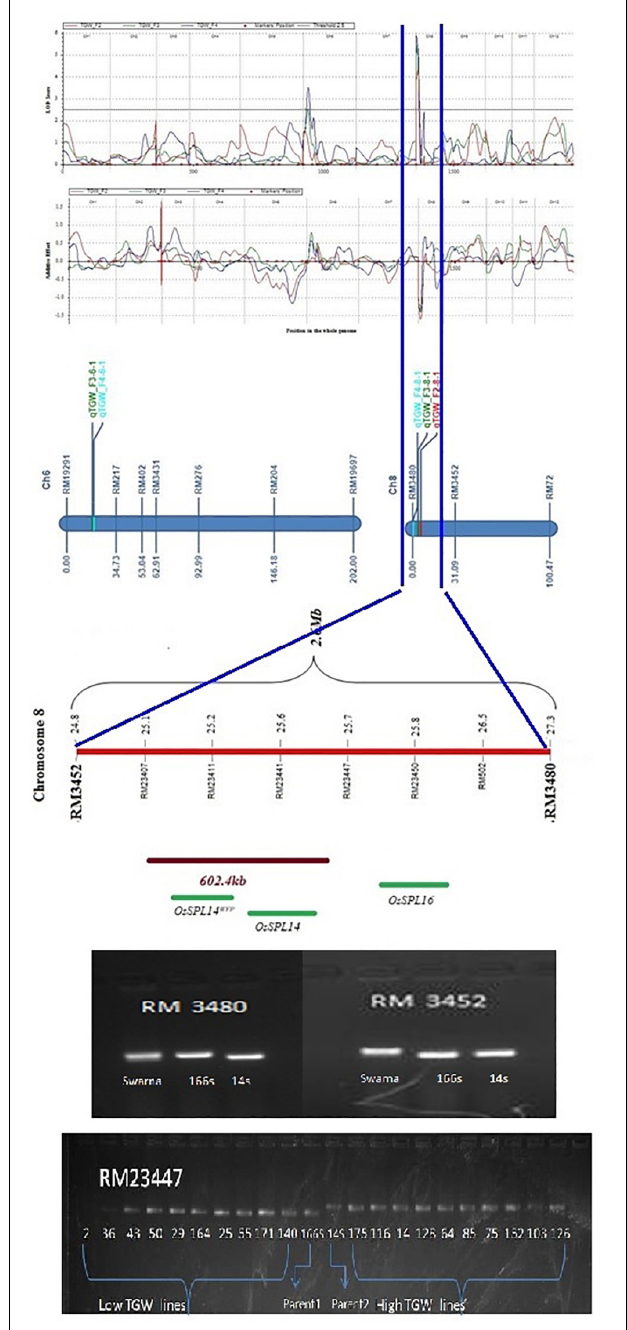
FIGURE 3 | Genetic dissection of qTGW8.1 QTL from 2.6 Mb region between RM3480-RM3452 and 602.4 Kb region between RM23407 and RM23447 based on genotypic segregation in high and low TGW phenotypes in F 4